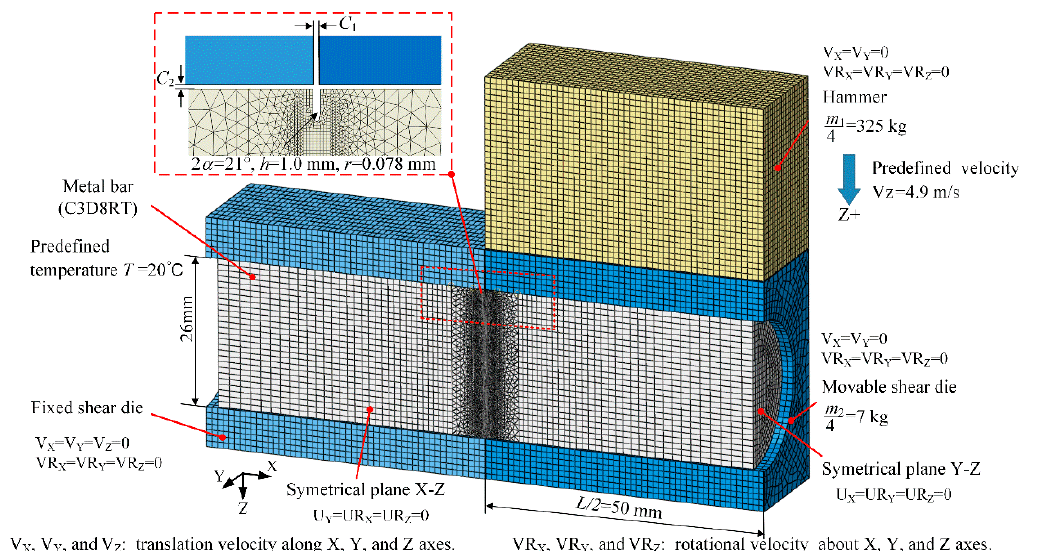
Figure 5. The FE model of the high-speed shearing. V X , V Y , V Z : translation velocity. VR X , VR Y , VR Z : rotational velocity. U X , U Y , U Z : translation displacement. UR X , UR Y , UR Z : rotational displacement.